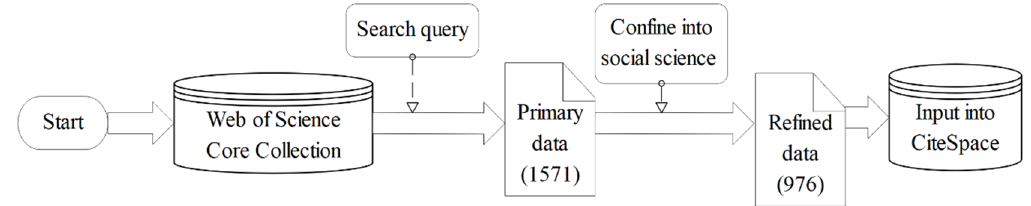
Figure 3. Flowchart of data acquisition before the bibliometric analysis.